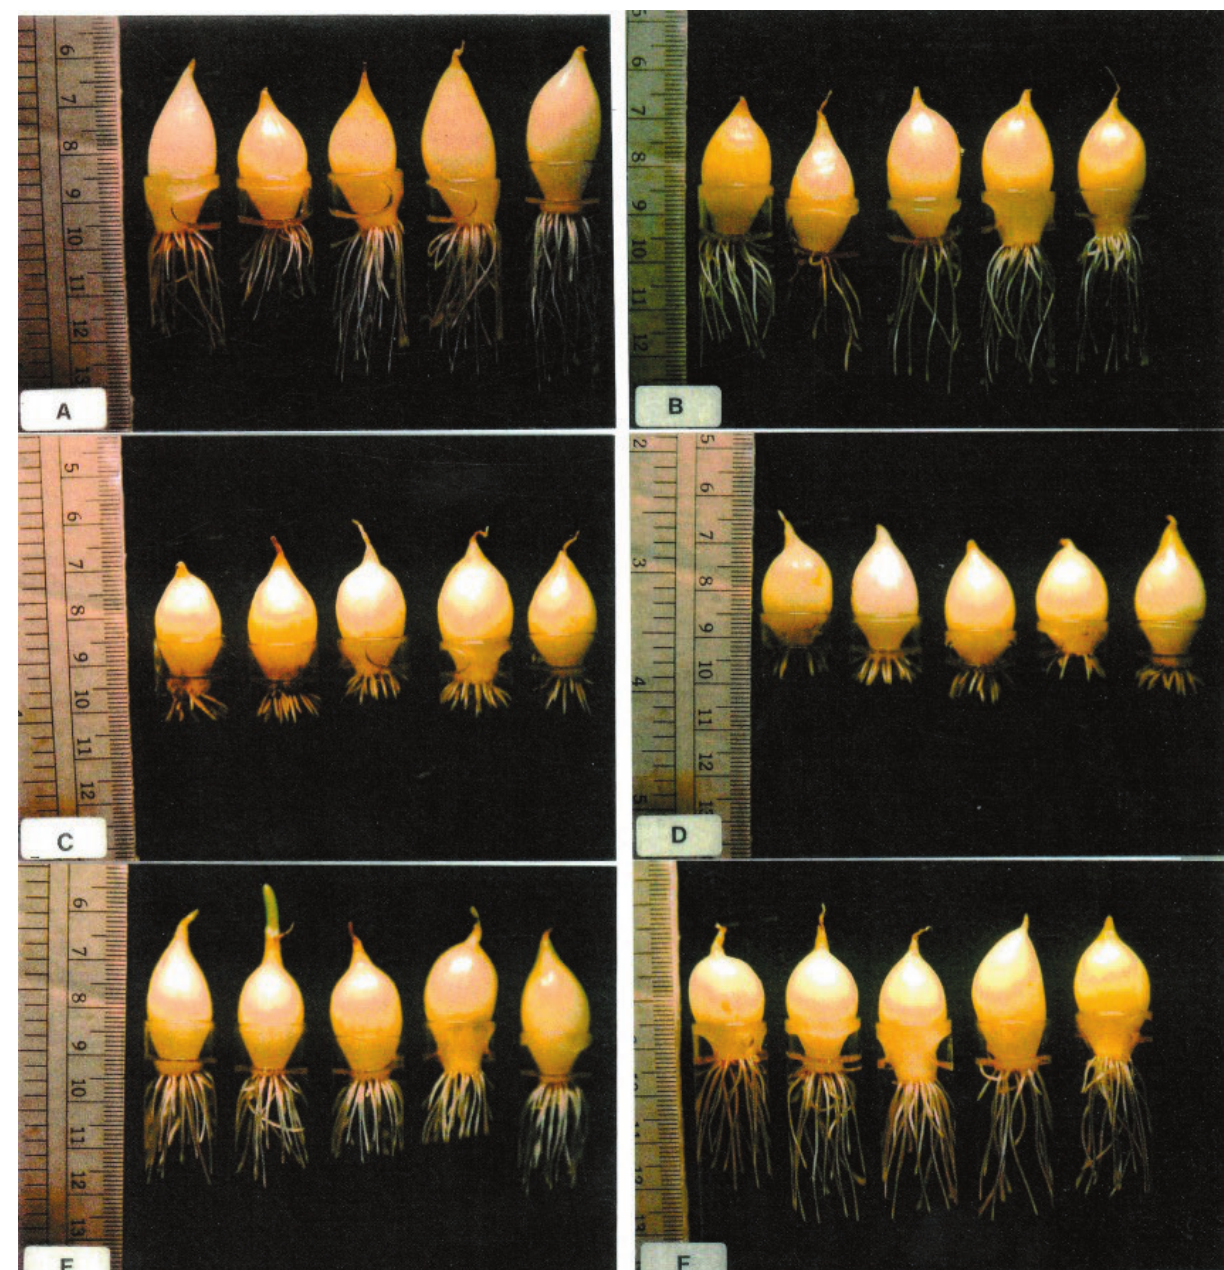
Figure 2. Examples of series of onions cultivated 72 h in different biotechnological and environmental river samples. A) Drinov rob, B) Študa, C) wastewater, D) WW after mechanical step, E) final treated effluent, F)